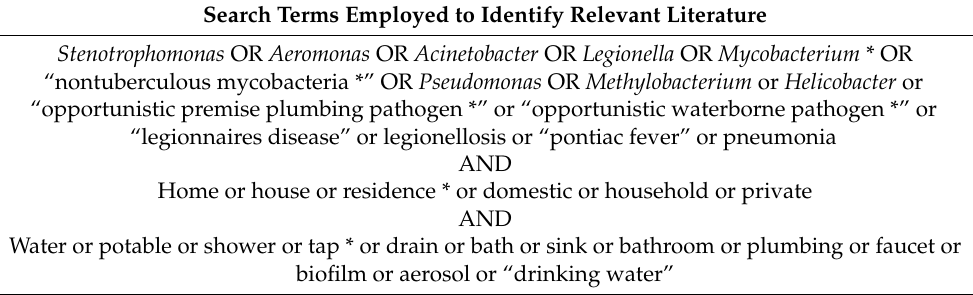
Table 1. Complete search strategy and all keywords used to identify relevant literature. Search Terms Employed to Identify Relevant